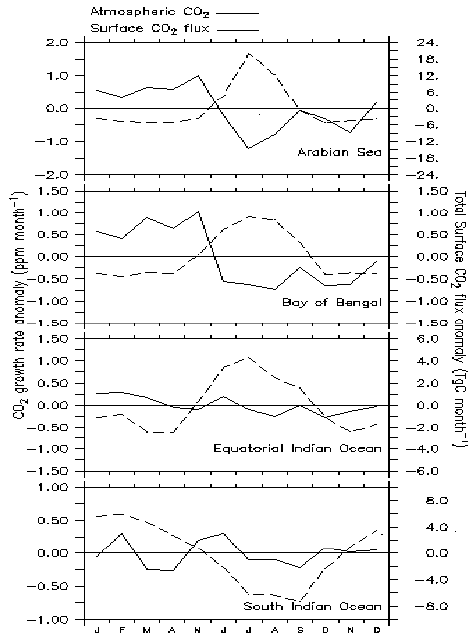
Figure 5 CO 2 growth rate anomaly compares with anomaly of air- sea fluxes of CO 2 over different basins of the TIO. Over the south TIO, the atmospheric CO 2 growth rate remains positive during most of the periods in a year except in the month of March and April. Estimated surface CO 2 fluxes remain negative during most of the period in a year except January- February. The relation between the anomalies of atmospheric CO 2 growth rate and surface fluxes over south TIO is much